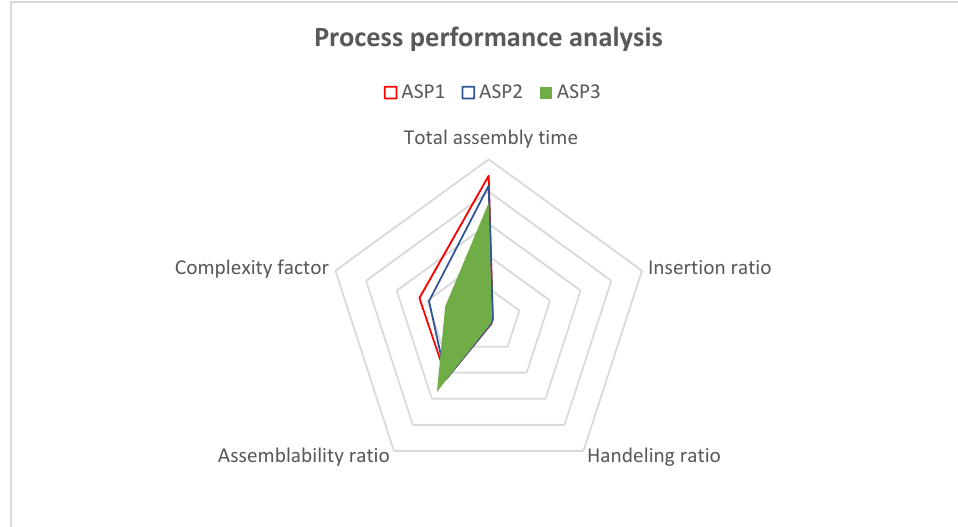
Figure 12. Process performance analysis of ASP1, ASP2 and ASP3 .